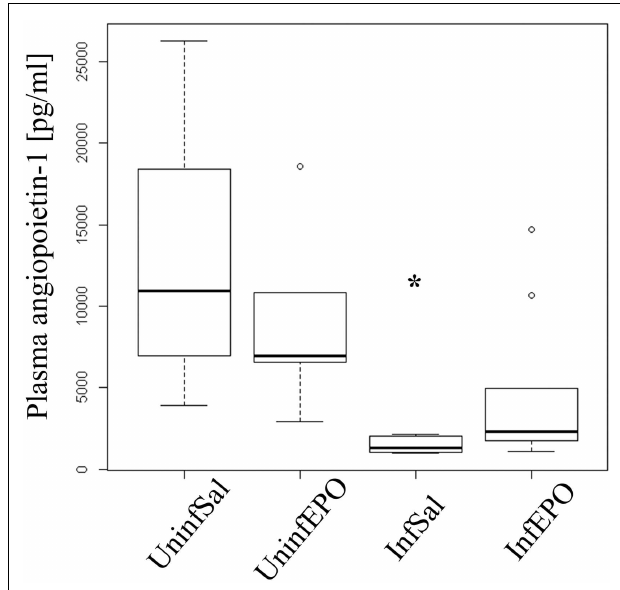
FIGURE 5 | Plasma angiopoietin-1 levels are affected by infection and EPO treatment. In terminal CM, plasma angiopoietin-1 levels were significantly decreased ( p = 0.004).The, InfEPO group also had lower levels of this cytokine but was statistically similar to uninfected mice ( p = 0.06). Box plots show median values and interquartile ranges.Whiskers show Tukey hinges; open circles are outliers. Asterisks denote significant deviations from uninfected, saline-treated